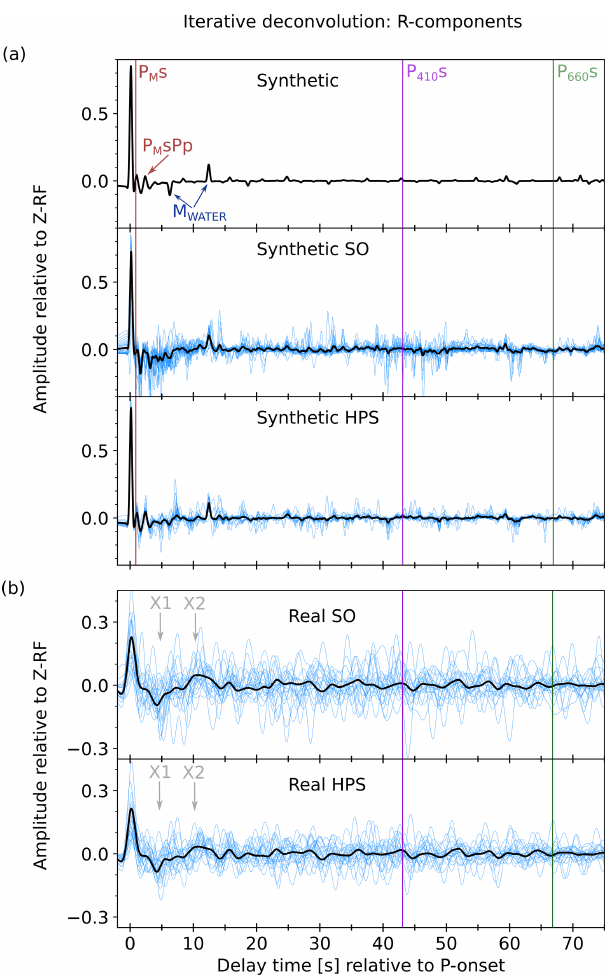
Figure 6. R-receiver function comparison of synthetic and real data examples. (a) Comparison of the synthetic data examples, low-pass- filtered at 2Hz. The pure synthetic R-RF is shown in the upper- most panel, followed by the synthetic SO and the synthetic HPS R-RFs. The black lines show the summed individual R-RFs (blue waveforms). The theoretical onset times for this specific model are marked. Red line: Ps arrival of the Moho (P M s) and its multiple (P M sPp), violet line: Ps arrival of the 410 (P 410 s), green line: Ps arrival of the 660 (P 660 s), dark blue arrows: multiples in the water column of 4.9km (M WATER ), repetitive every 6.5s. (b) Compar- ison of the real data, bandpass-filtered at 0.05–0.5Hz. The upper panel shows the R-RFs of the real SO traces and the lowermost panel the R-RFS of the real HPS traces. The individual traces (blue) are shown as a stack (black line), and the theoretical onset times based on the average ak135 velocity model are shown as a violet line (P 410 s) and green line (P 660 s). The origin of the phases X1 and X2 (gray) remains unclarified, since their interpretation is beyond the scope of this